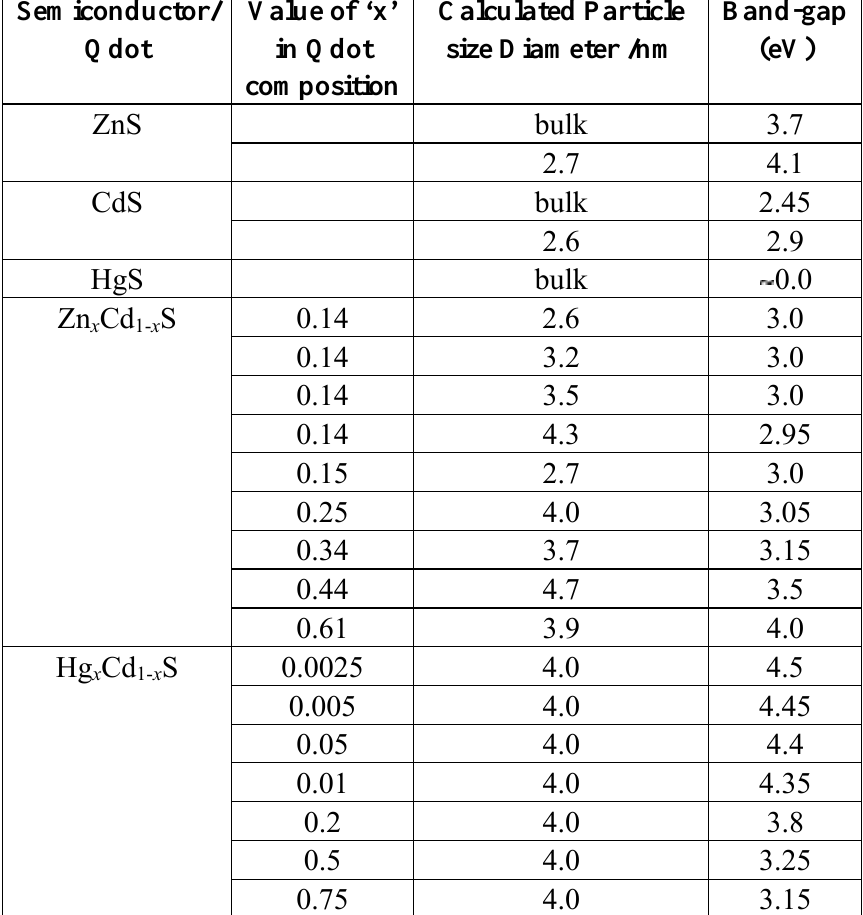
Cd S alloy (Adapted from x 1-x